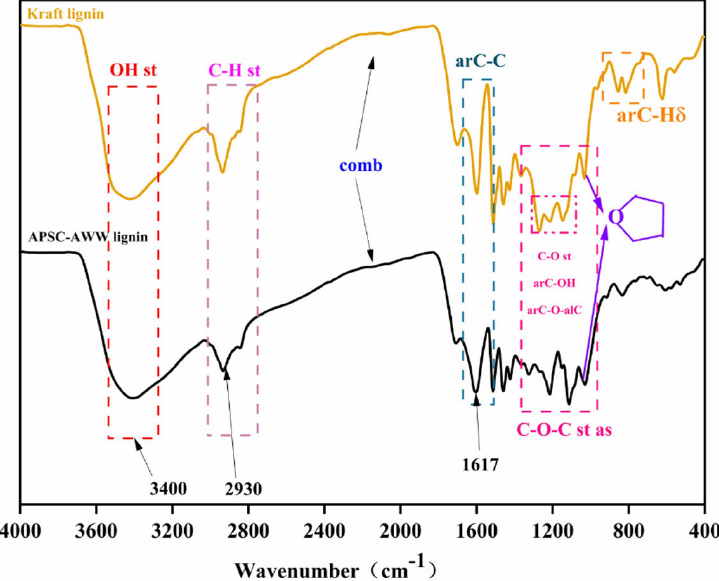
Figure 7. FTIR of APSC-AWW lignin and kraft lignin.